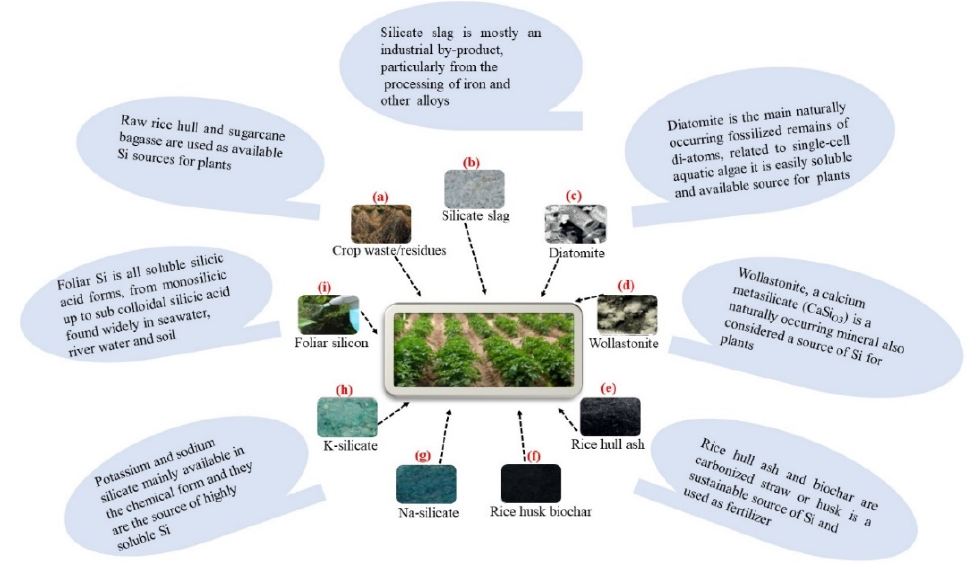
Figure 2. Different sources of Si fertilizer used in agricultural applications. ( a ) Crop raw rice hull, ( b ) silicate slag, ( c ) diatomite, ( d ) wollastonite, ( e ) rice hull ash, ( f ) biochar carbonized straw or husk, ( g ) sodium silicate, ( h ) potassium silicate, and ( i ) foliar Si soluble silicic acid forms, right from monosilicic to subcolloidal silicic acid [98,99] .